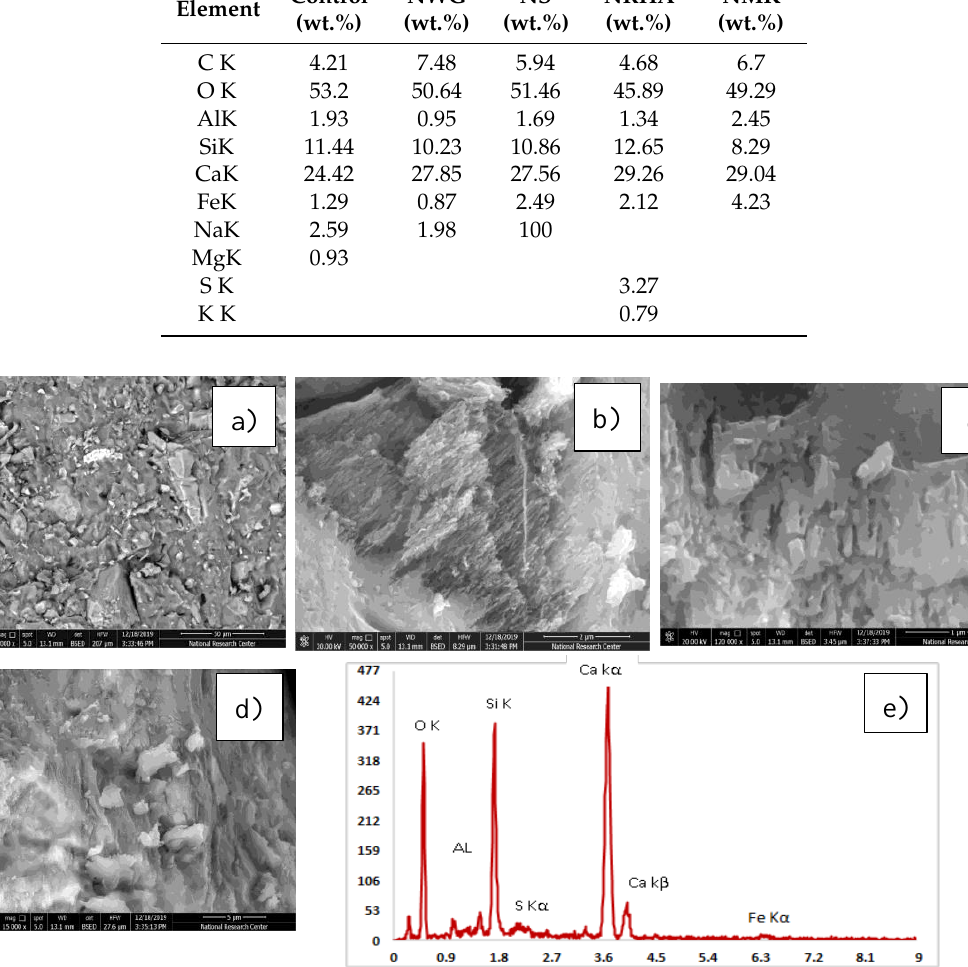
Table 5. EDX results in di ff erent UHPC mixes with and without nanoparticles.